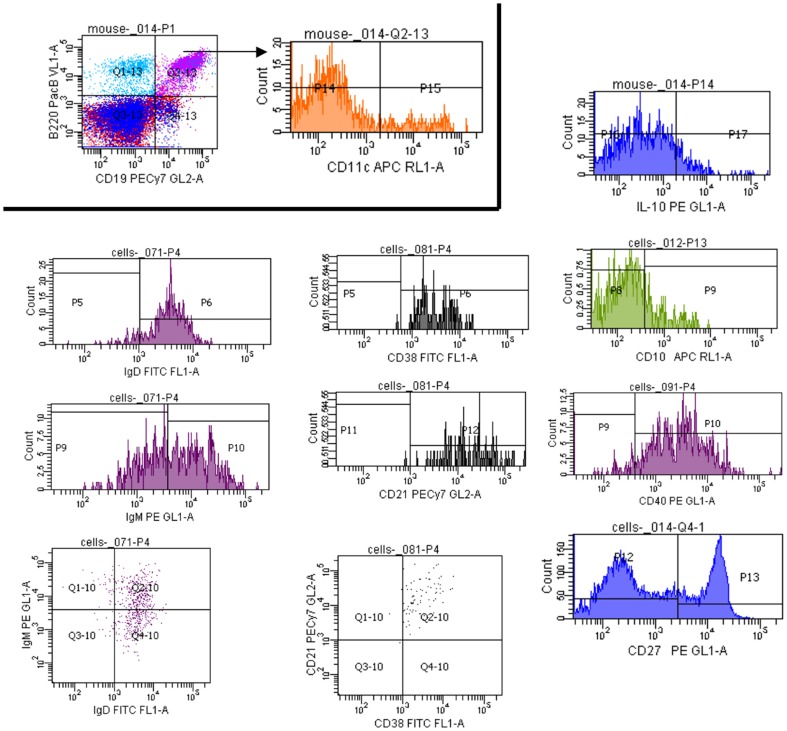
Flow cytometric characterisation of splenic DC-Bregs from NOD mice.Gating was established as shown (CD19+ B220+ CD11c−). The frequency of cells expressing each of the surface proteins indicated in the histograms inside this gate further established the phenotype of the DC-Bregs in freshly-isolated spleen of NOD female mice (10 weeks of age). The data shown are representative of the flow cytometric anlyses of freshly-acquired splenocytes from three different age-matched NOD mice. Surface markers include IgD, IgM, CD10, CD21, CD27, CD38 and CD40.